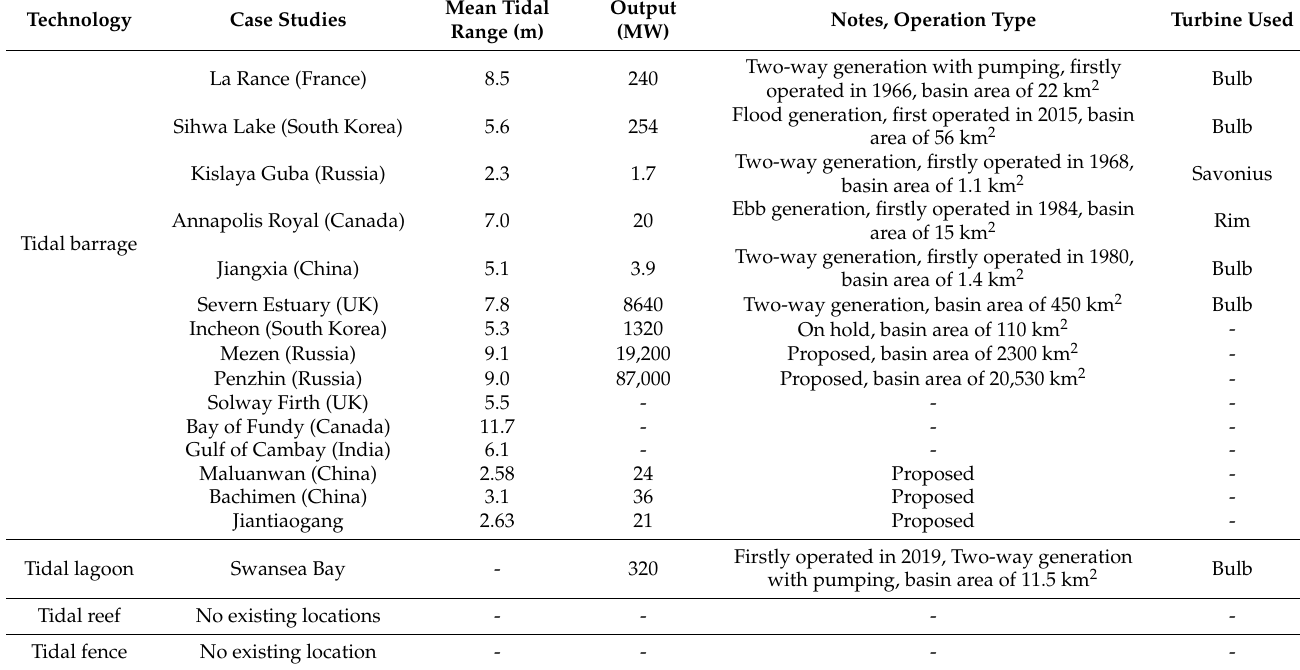
Table 5. Studies and projects related to tidal range